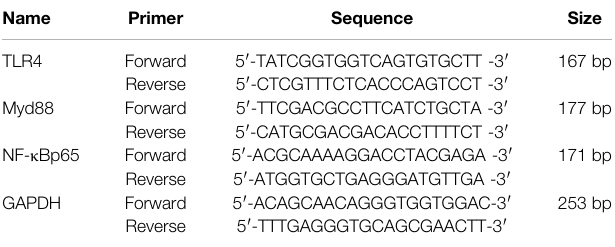
TABLE 2 | Primer sequences for real-time quantitative